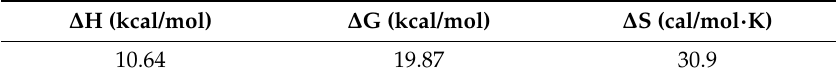
Table 4. The thermodynamic properties during preparing (C 2 H 5 ) 3 Al process.